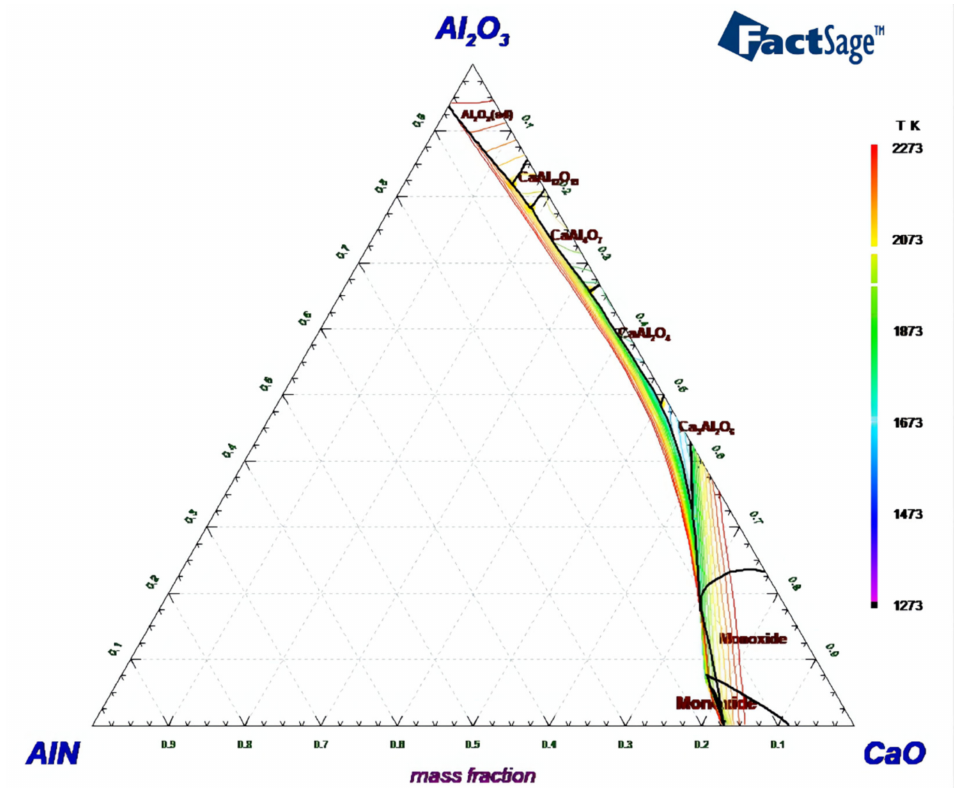
Figure 2. CaO-Al 2 O 3 -AlN ternary phase diagram for p = 1 atm, drawn with FactSage 7.2.